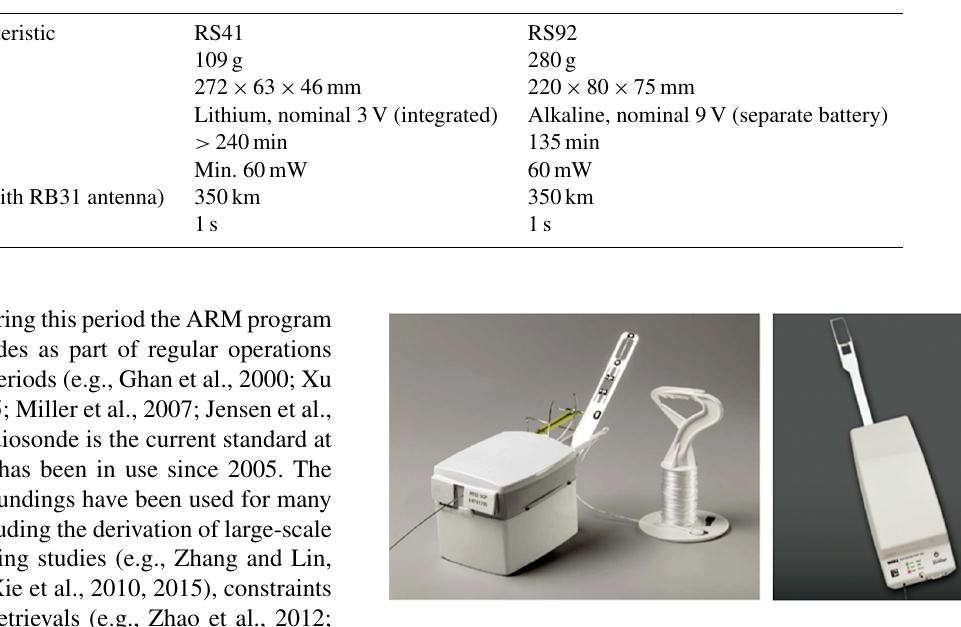
Figure 1. Picture of two radiosonde types used in this study: RS92 (left) and RS41 (right).